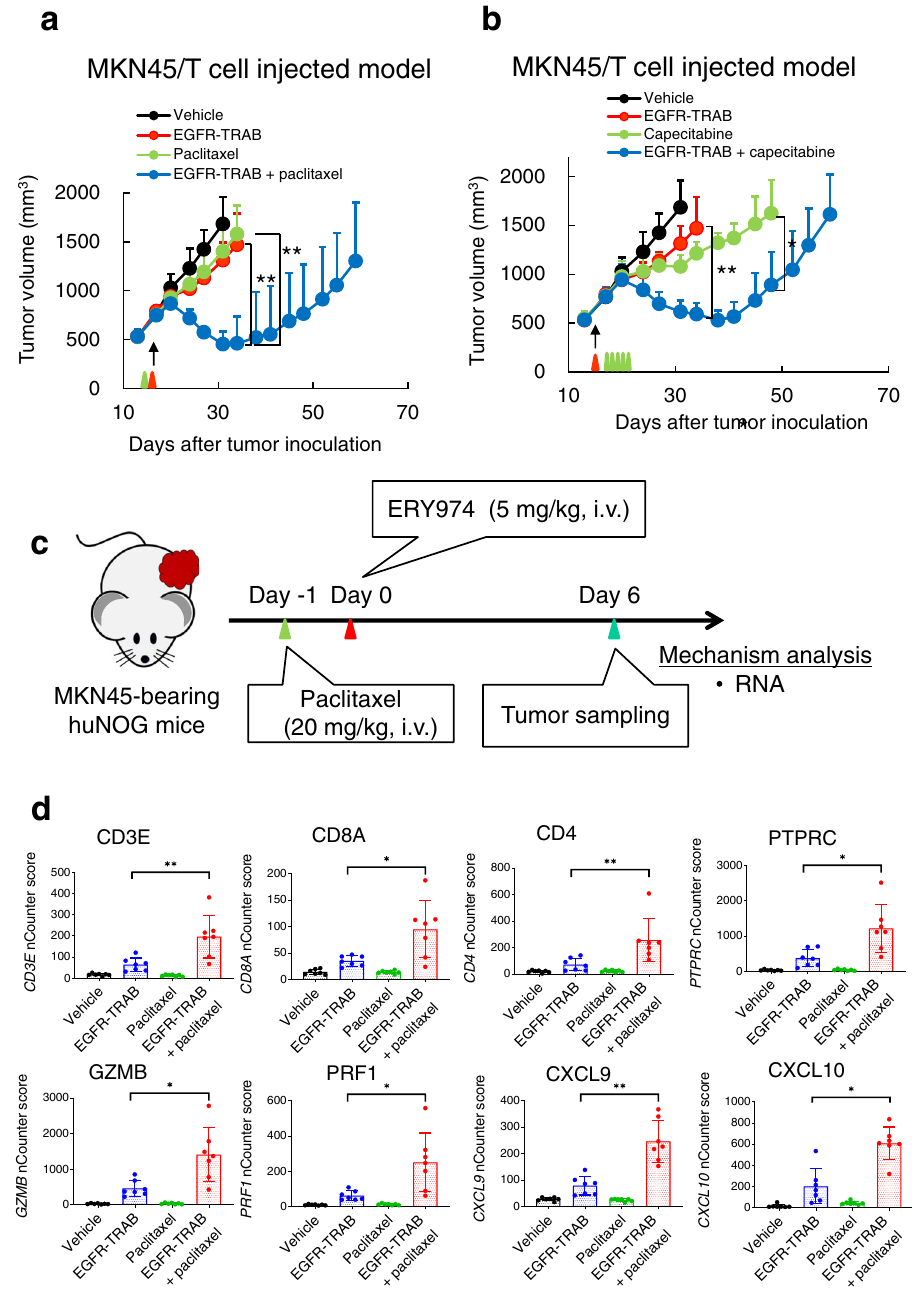
Fig. 9 | Combination of EGFR-TRAB and chemotherapy shows more ef fi cacy than EGFR-TRAB or chemotherapy alone in non-in fl amed MKN45 tumours. a Antitumour ef fi cacy of EGFR-TRAB combined with paclitaxel in MKN45 tumours in T cell-injected model. EGFR-TRAB (5mg/kg) and paclitaxel (20mg/kg) were administered. Red and green arrows indicate the timing of EGFR-TRAB and pacli- taxel administration, respectively. Black arrow indicates the timing of T cell administration. Tumour volumesare presented asthe mean±SD( n =5). Statistical signi fi cance was evaluated using the Wilcoxon chi-square test (** P <0.01). Exact p values of ERY974 versus combination and capecitabine versus combination on day 34 are both 0.0090. b Antitumour ef fi cacy of EGFR-TRAB combined with capecitabineinMKN45tumoursinTcell-injectedmodel.EGFR-TRAB(5mg/kg)and capecitabine (359mg/kg) were administered. Red and green arrows indicate the timing of EGFR-TRAB and capecitabine administration, respectively. Black arrow indicatesthetimingofTcelladministration.Tumourvolumesarepresentedasthe